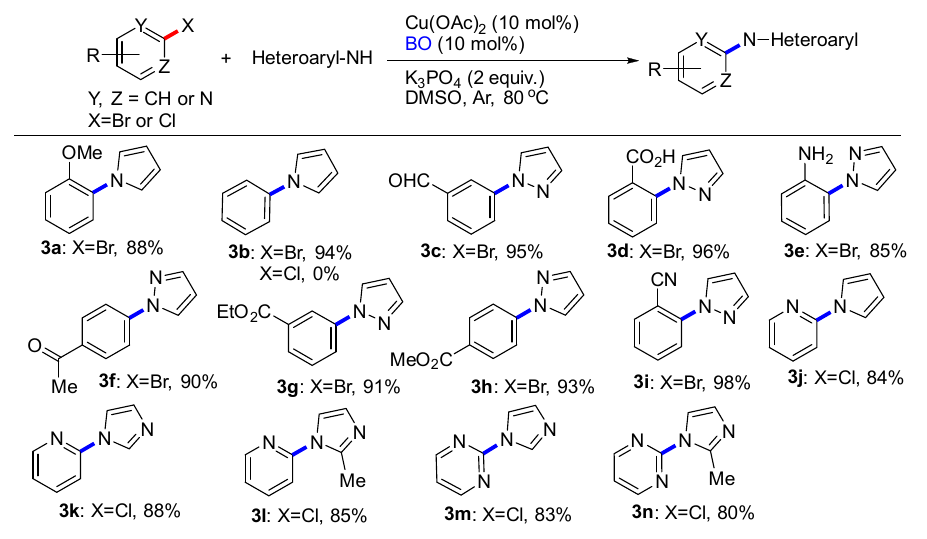
Table 2. C-N Coupling reactions of substituted aryl compounds with pyrrole or azoles a,b .